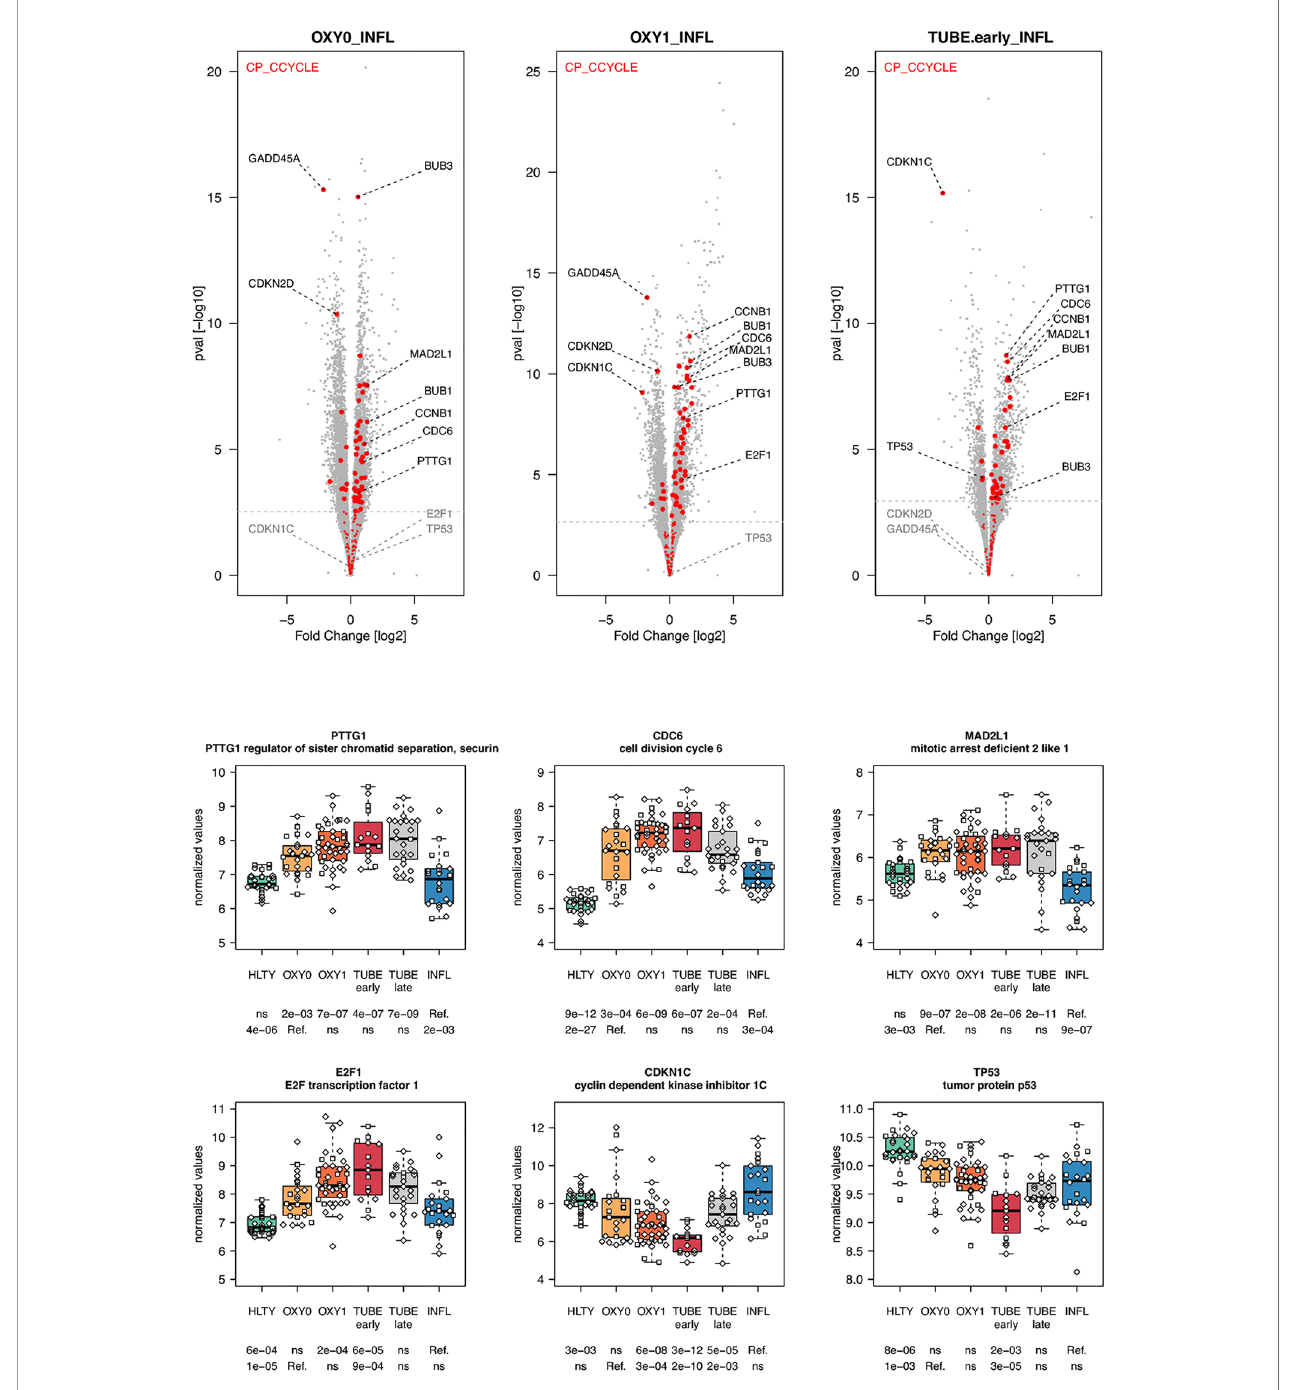
FIGURE 12 | Differentially expressed genes (DEGs) involved in cell cycle. Upper panel: for each comparison indicated in the volcano plot header, the distribution of log2 fold changes and P-values of all detected genes is shown as gray dots. Red dots indicate genes involved in cell cycle. Genes ’ sets are selected from different GO, REACTOME and/or KEGG pathways (see Supplementary Table 2 ). The dotted horizontal gray line indicates the limit under which – log10(P-value) becomes non signi fi cant once adjusted for multiple testing (adjusted P > 0.01). Lower panel shows detailed expression levels of selected genes involved in cell cycle in the different groups of patients. Groups used for comparisons include SARS-Cov-2 infected patients (no oxygen support [OXY0], oxygen support [OXY1], intubation with sampling within 7 days [TUBE early] or >7 days [TUBE late] after hospital admission), In fl uenza virus [INFL] infected patients and non-infected controls [HLTY]. Adjusted P-values of pairwise comparisons between a reference group (Ref.) and another group are indicated below the x axis. Ref. is taken as [INFL] and [OXY0] on the fi rst and second line,